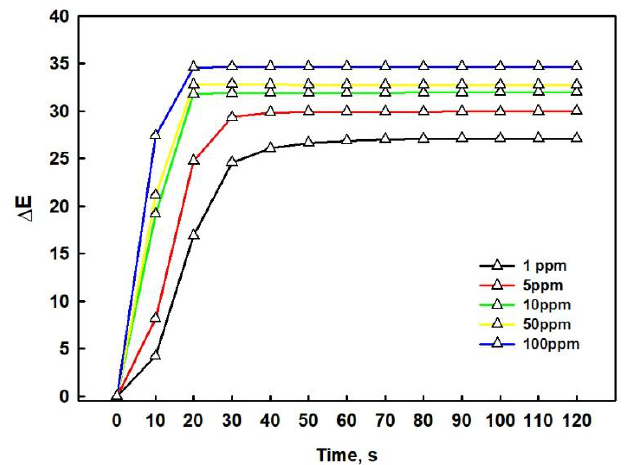
Figure 5. Time-dependent color differences of printed sensor for gaseous HCl at concentrations from 1 to 100 ppm. Table 3. Color data of dyed sensors after exposure to various concentrations of gaseous HCl. ppm ppm